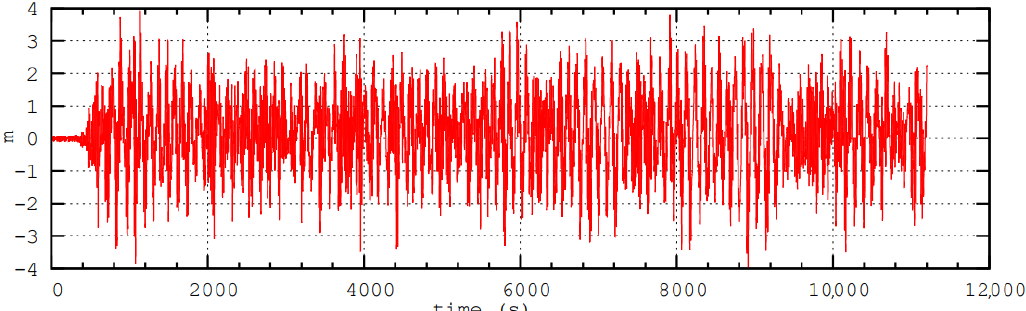
Figure 9. IW8 wave series according to experiments (Hs = 10.0 m, Tp = 14.0 s).